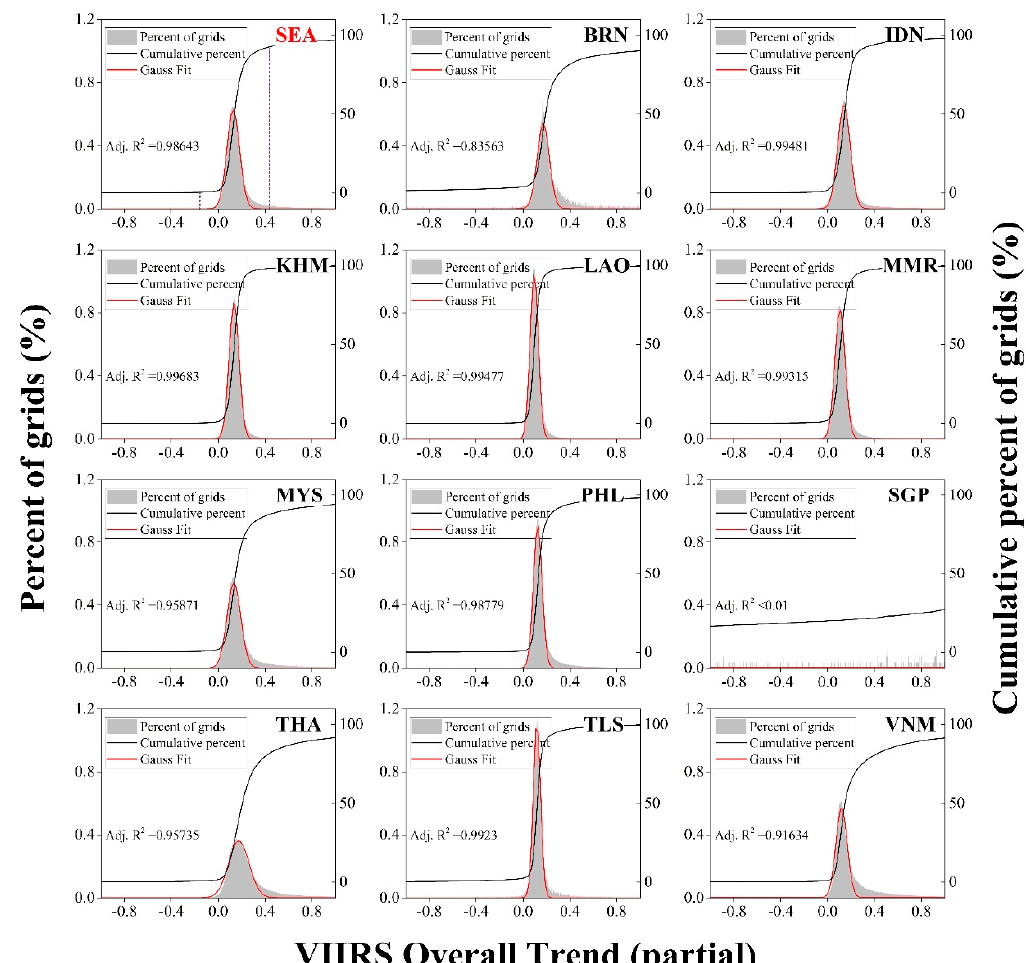
Figure 3. Frequency histogram shows the percent of all grid counts under different VIIRS/DNB overall trend ranges (trend interval: 0.01, partial not total, grid count: ≈ 21.41 × 10 6 ), and the cumulative frequency curve shows the cumulative percent of grid counts for the whole Southeast Asia (SEA) region and 11 countries. The Gaussian fit curve shows the fitted distribution of the VIIRS